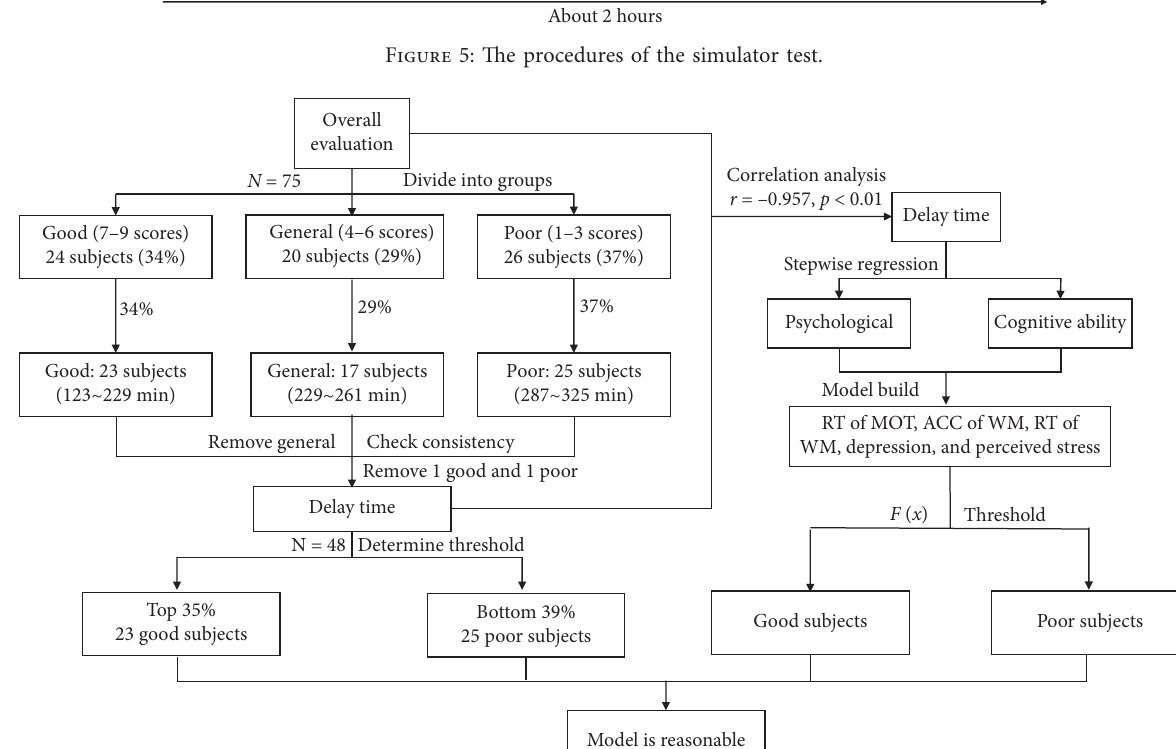
Figure 6: Data analysis procedures.